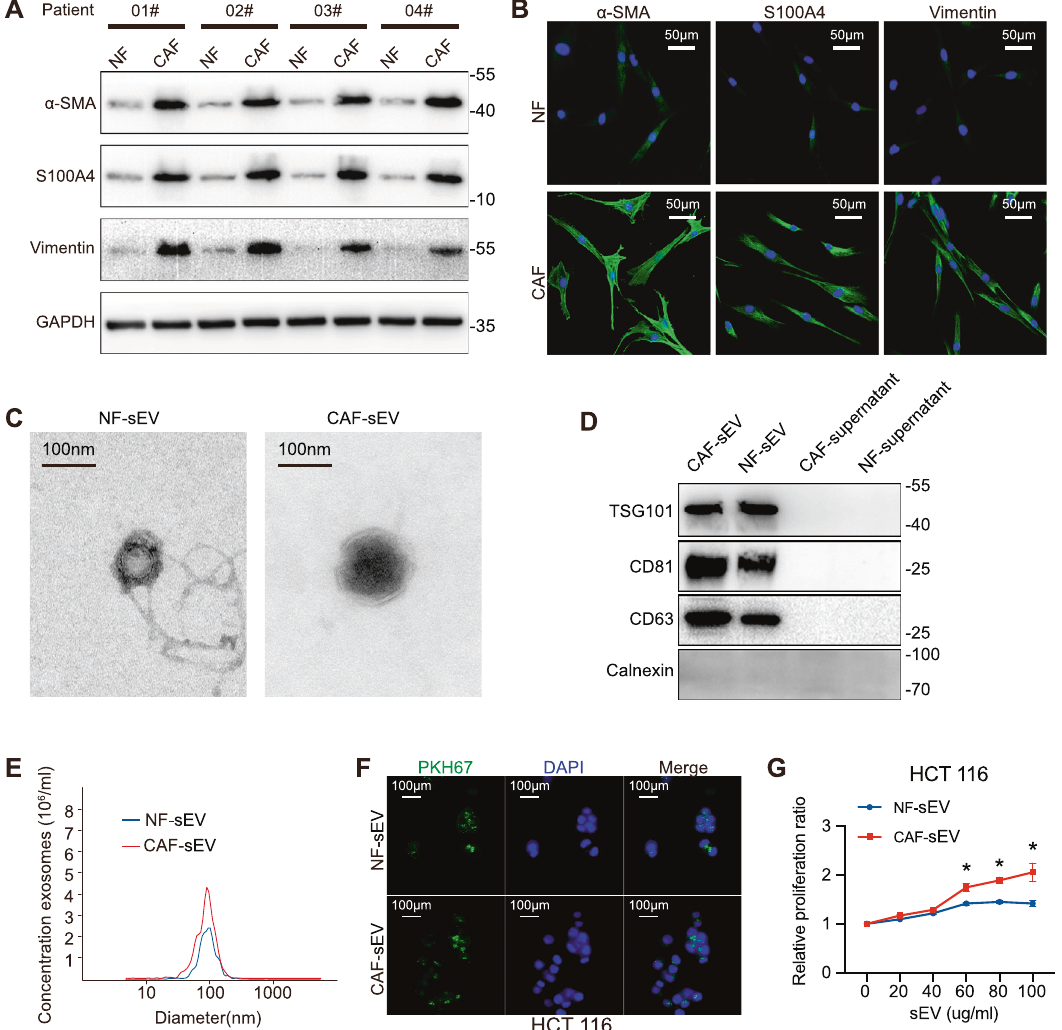
Fig. 1 Extraction and identi fi cation of fi broblasts and sEVs. A , B Western blot and immuno fl uorescence staining for α -SMA, S100A4, and Vimentin expression of NFs and CAFs (scale bar, 50 μ m). C – E Identi fi cation of medium sEVs of NFs and CAFs by transmission electron microscopy (scale bar, 100 nm), western blot, and NTA (nanoparticle tracking analysis). F sEVs labeling and tracing (scale bar, 100 μ m). G A CCK8 assay detection of cell viability. Cell proliferation ratio: different EVs group /PBS group . Data are presented as the mean ± SD. * P <